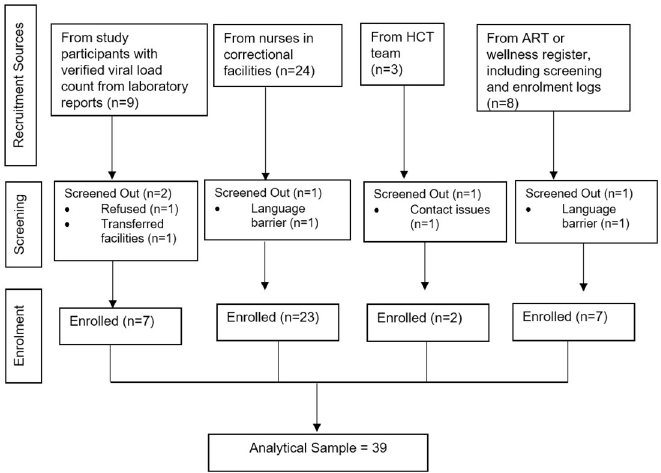
Fig 1. Flow diagram of participants for in-depth interviews (n = 30) in the Treatment as Prevention qualitative sub-study from 31 March 2017–31 March 2018 in Gauteng and Western Cape provinces, South Africa.